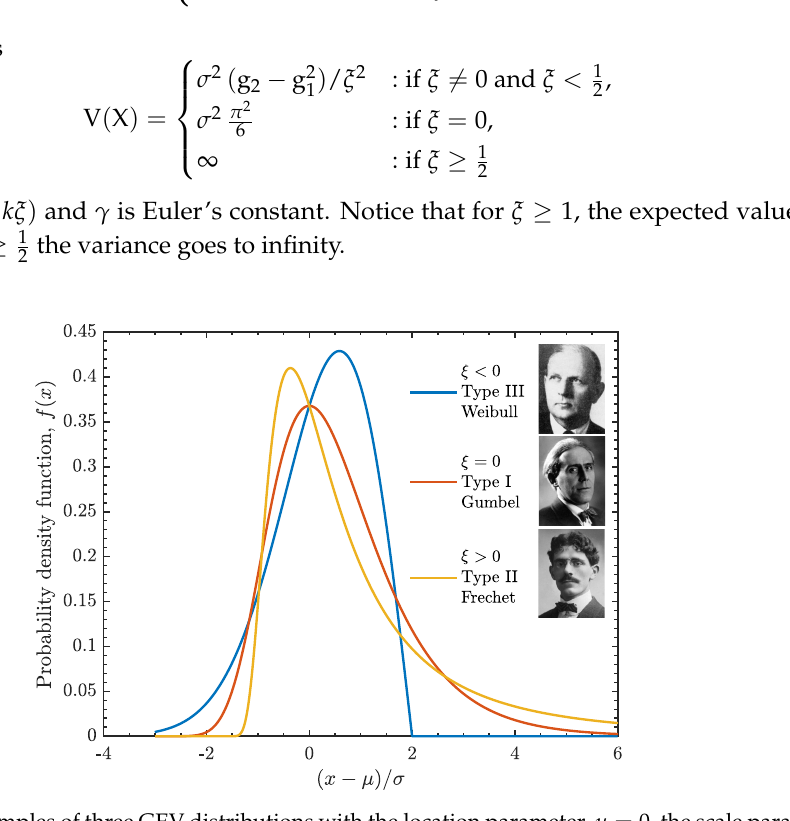
Figure A1. Examples of three GEV distributions with the location parameter, µ = 0, the scale parameter, σ = 1. and three values of the shape parameter i.e., ξ < 0 (Weibull), ξ = 0 (Gumbel) and ξ > 0